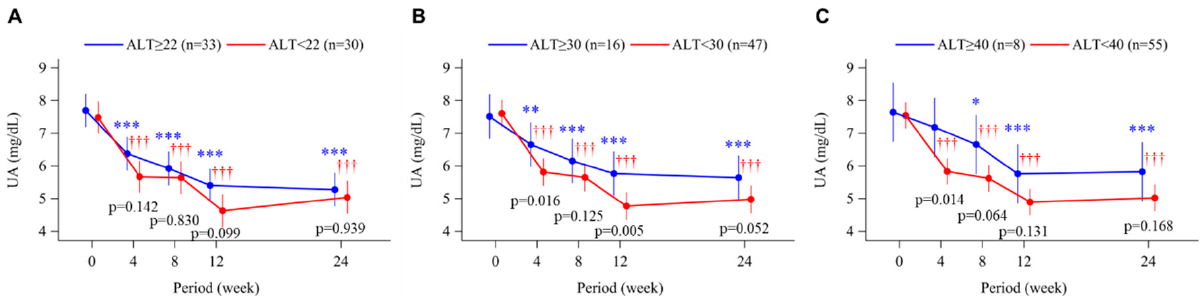
Figure 3. Time course of changes in serum uric acid from baseline to week 24 in the topiroxostat- treated group. Patients were divided into groups according to baseline alanine aminotransferase (ALT) level, above or below 22 U/L (median; A ), 30 U/L ( B ), and 40 U/L (upper limit of normal; C ). Points and bars represent the least-squares mean and 95% confidence interval values using a mixed-effects model with repeated measures adjusted for sex and age. p-values within each graph are for the between-group difference in change from baseline. * p < 0.05, ** p < 0.01, and *** p < 0.001 for change from baseline in the ALT-high group. ††† p < 0.001 for change from baseline in the ALT-low group.